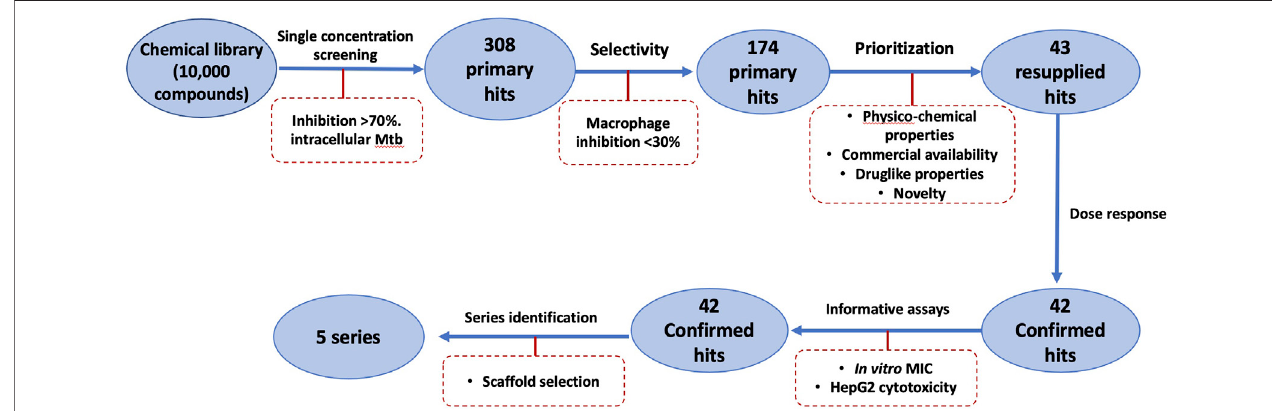
FIGURE 1 | Schematic of High Throughput Screening (HTS) of a library of small